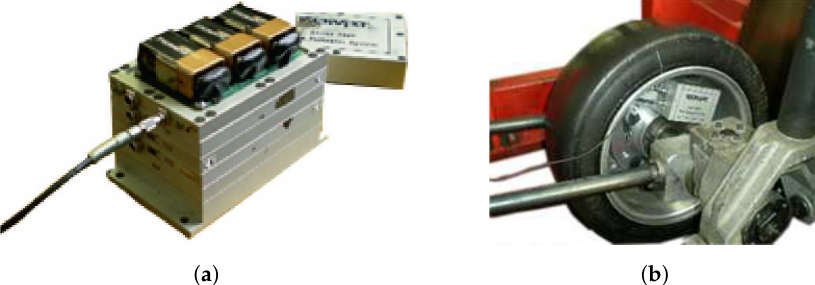
Figure 3. Acquisition system SoMat ® 2000: ( a ) Microprocessor for the data acquisition, and a Power/Communication module; ( b ) Data acquisition module installed on the tire